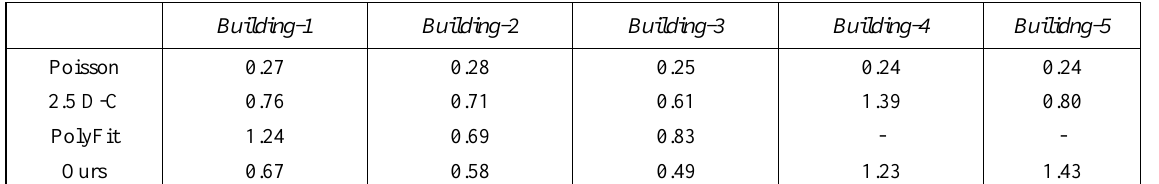
Table 2. RMSE measurements (m) of building reconstruction results of different methods.